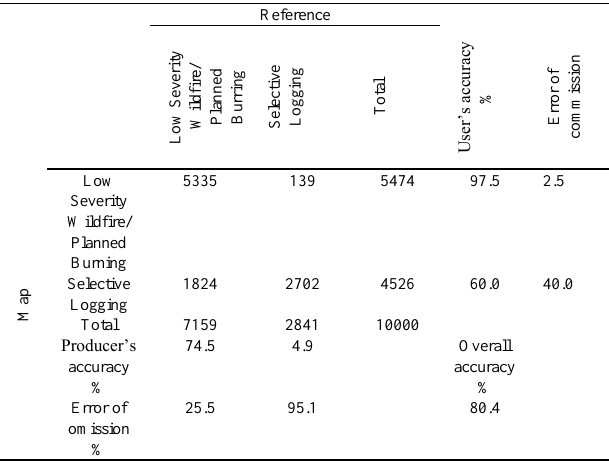
Table 2: Confusion matrix for predicting disturbance agents in low severity disturbance classes